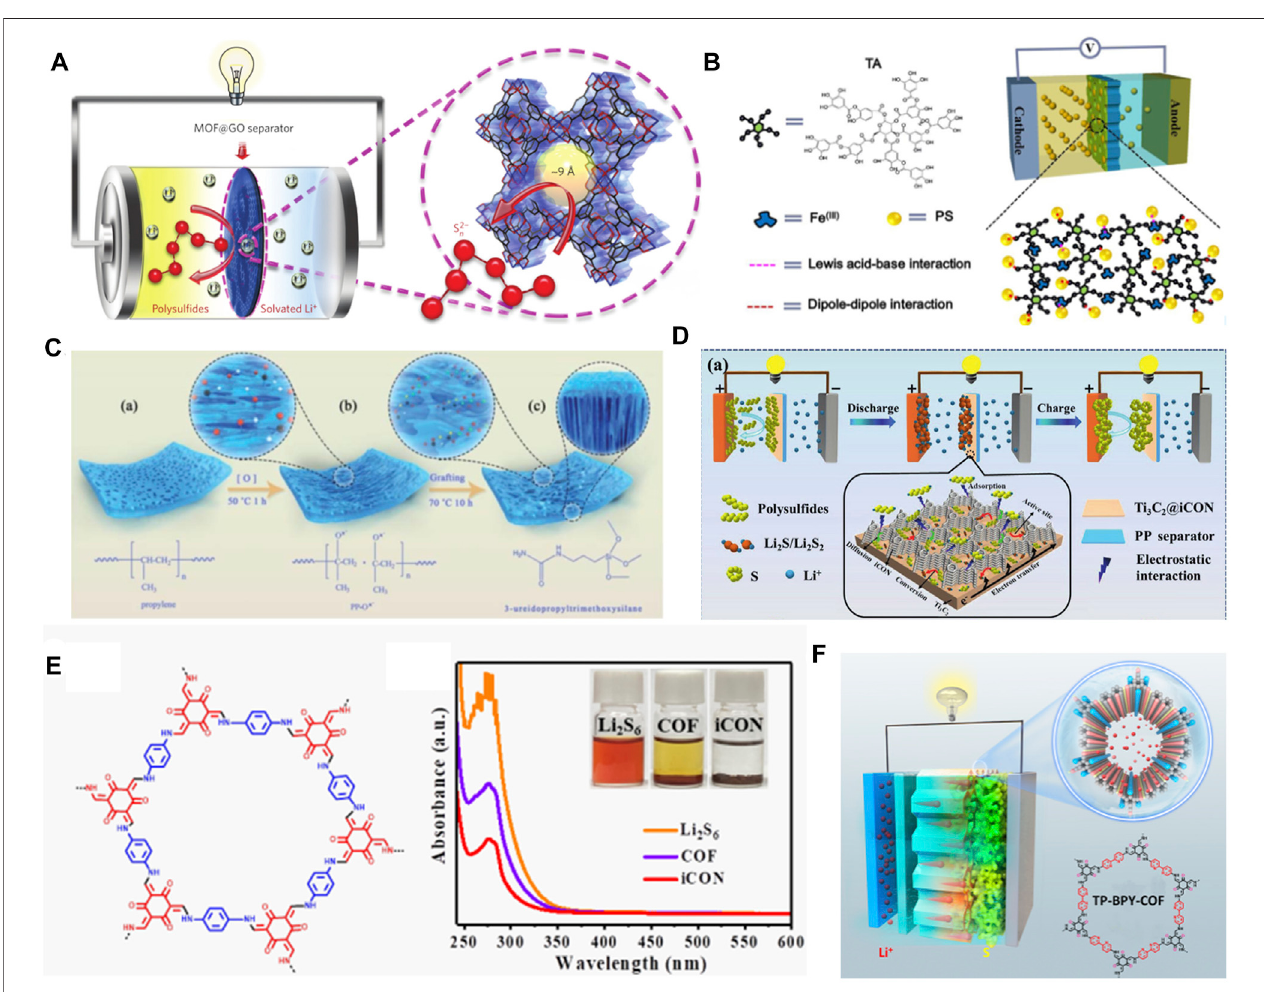
FIGURE5 | Typical strategies forseparator modifying byorganic electrocatalysts inLi − Sbatteries. (A) The concept ofionic sieve by MOF@GOmodi fi ed separator for inhibiting thedissolution ofLiPSs. (A) Figure reproducedfromthe datainBai etal.(2016). (B) Schematicillustration ofTA/Fe 3+ -PPseparators. (B) Figurereproduced from the data in Zhang H. et al. (2018). (C) The preparation process of the PP-O x- -U functionalized separators. (C) Figure reproduced from the data in Zhou H. et al. (2020). (D) Effects of Ti 3 C 2 MXenes in Ti 3 C 2 @iCON modi fi ed separators for improving the electrochemical performance. (E) The structure of charge-neutral COF containing β -ketoene units and UV-vis absorption spectra and digital photographs (inset) of Li 2 S 6 solution after the addition of iCON. (D, E) Figure reproduced from the data in Li P. et al. (2021). (F) The design strategy of TP-BPY-COF-modi fi ed separators. (F) Figure reproduced from the data in Xu et al. (2019).